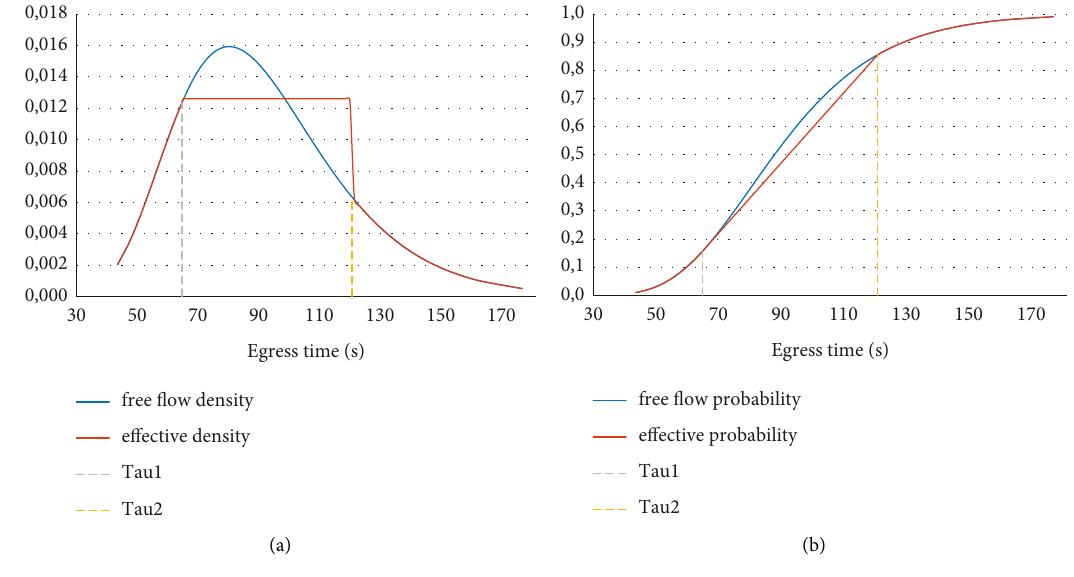
Figure 2: PDF (a) and CDF (b) of egress